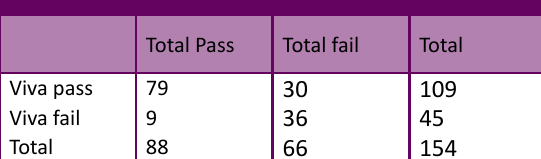
Table 1 – Mean and standard deviation of marks for the individual components Component Mean (%)